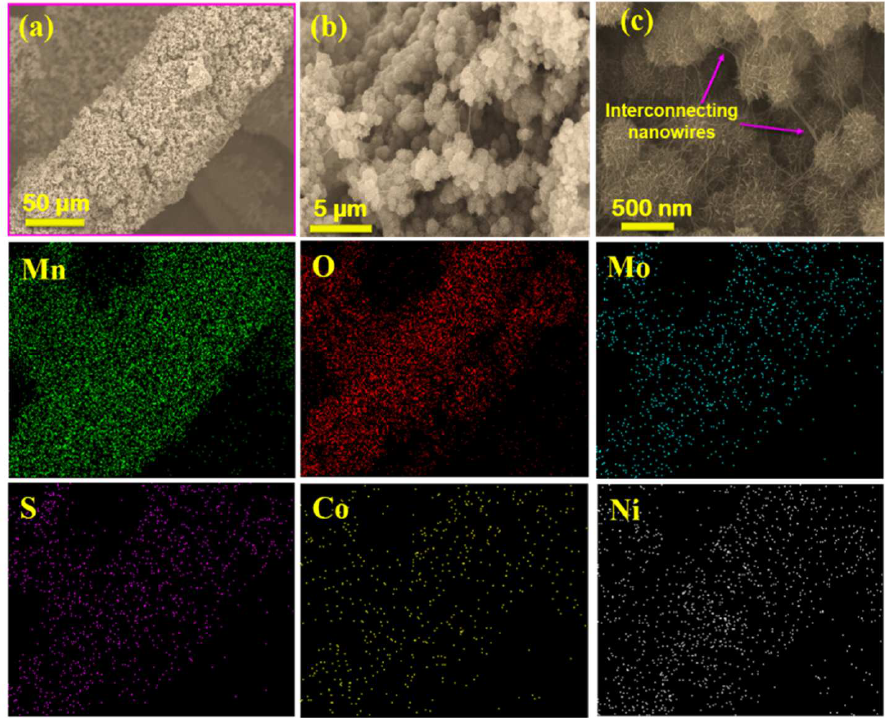
Figure 3. SEM images of NCMSM at different magnifications ( a – c ) and the corresponding elemental mapping for Mn, O, S, Mo, Co, and Ni.